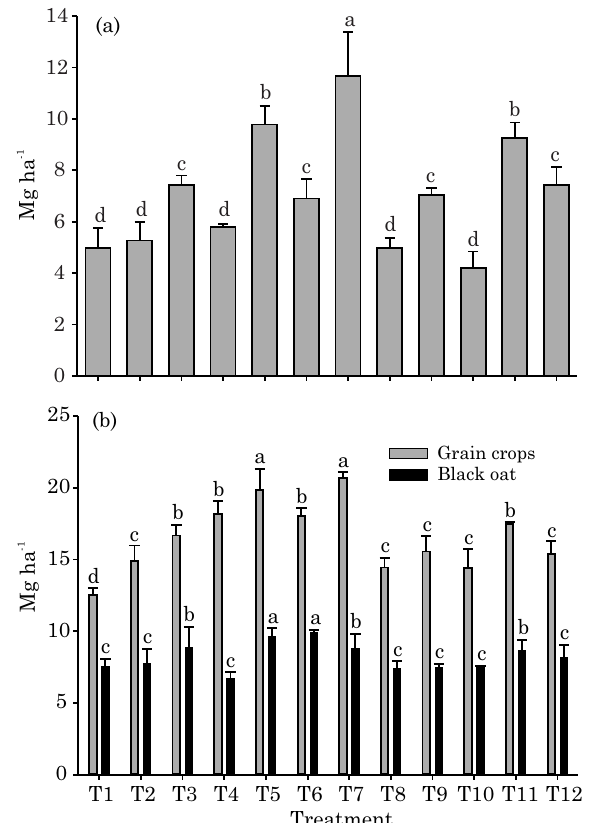
Figure 3. Accumulated grain yield (a) of common bean (2005/06) and maize (2006/07 and 2007/08) crops, and accumulated dry matter production (b) of the grain crops and black oat of the crops grown in the 2005 to 2008 growing seasons. T1 - without application; T2 - 10 m 3 ha -1 PS; T3 - 10 m 3 ha